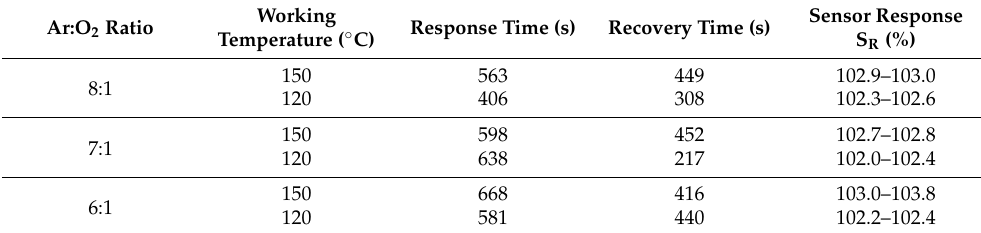
Table 2. Summary of the gas sensing